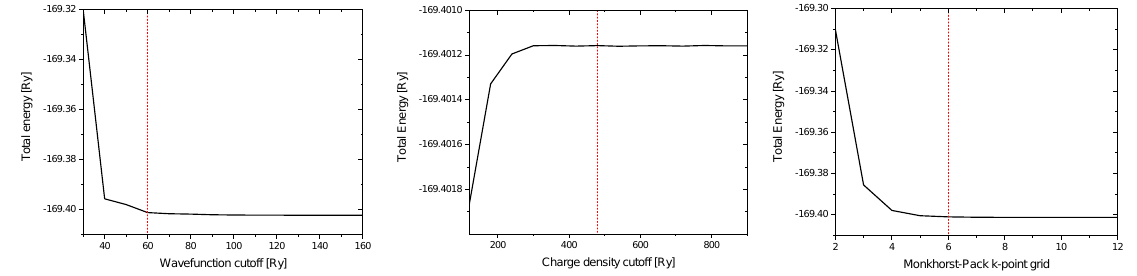
Figure A1. Convergence tests of the kinetic cutoff for wavefunctions ( left ), the kinetic cutoff for the charge density ( middle ) and the Monkhorst-Pack k-point grid ( right ).